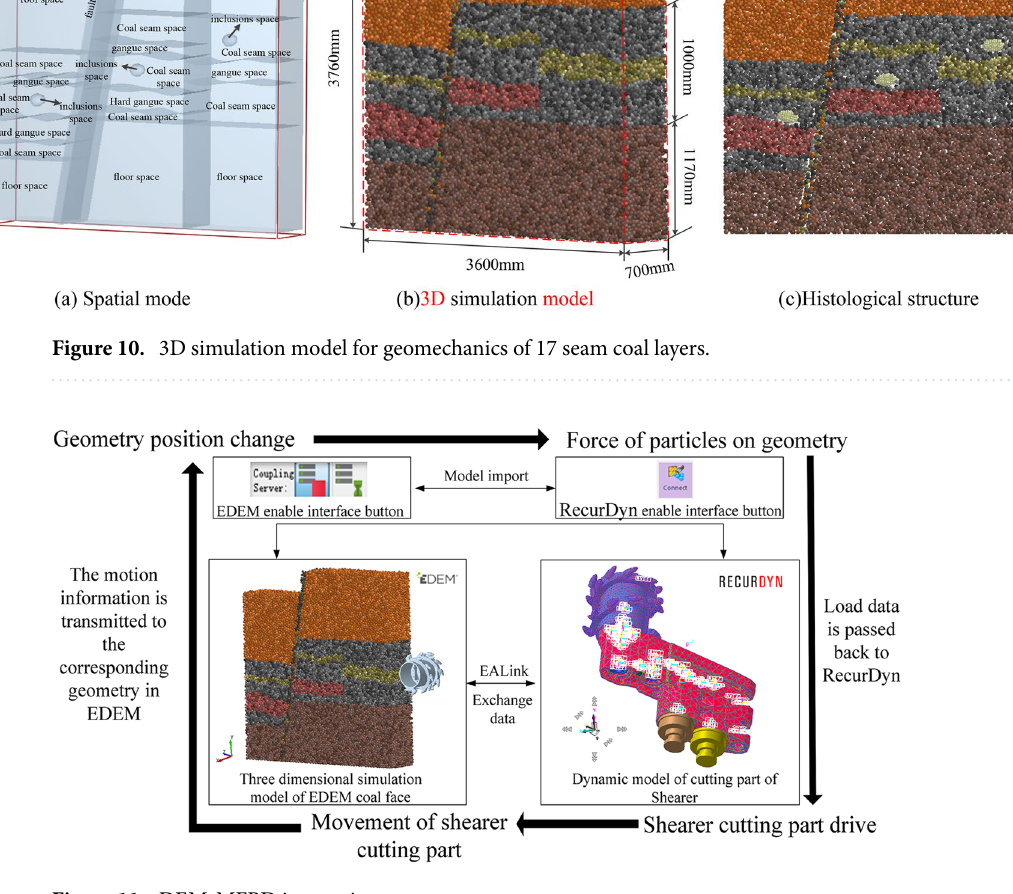
Figure 11. DEM-MFBD interaction